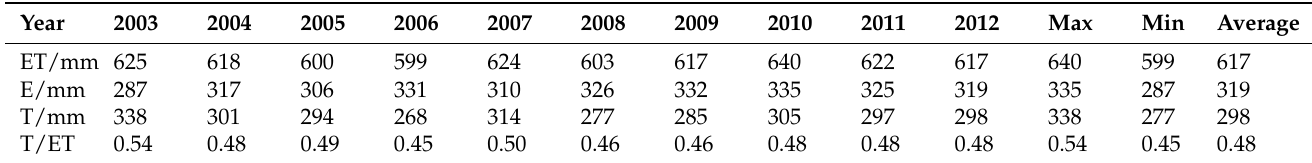
Table A2. Total ET, soil evaporation (E), and vegetation transpiration (T) of agricultural land during the growing seasons from 2003 to 2012.